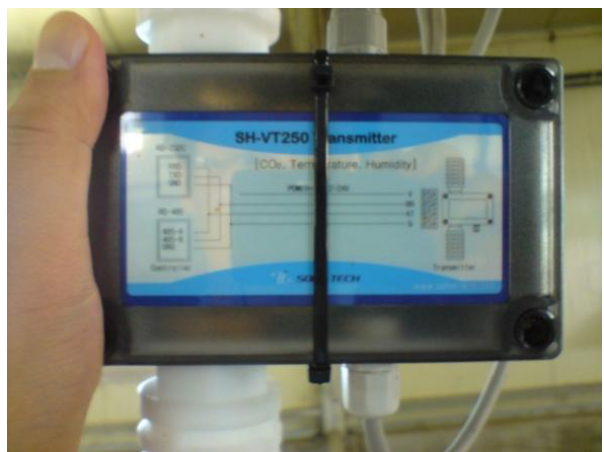
Figure 11. Wired Integrated